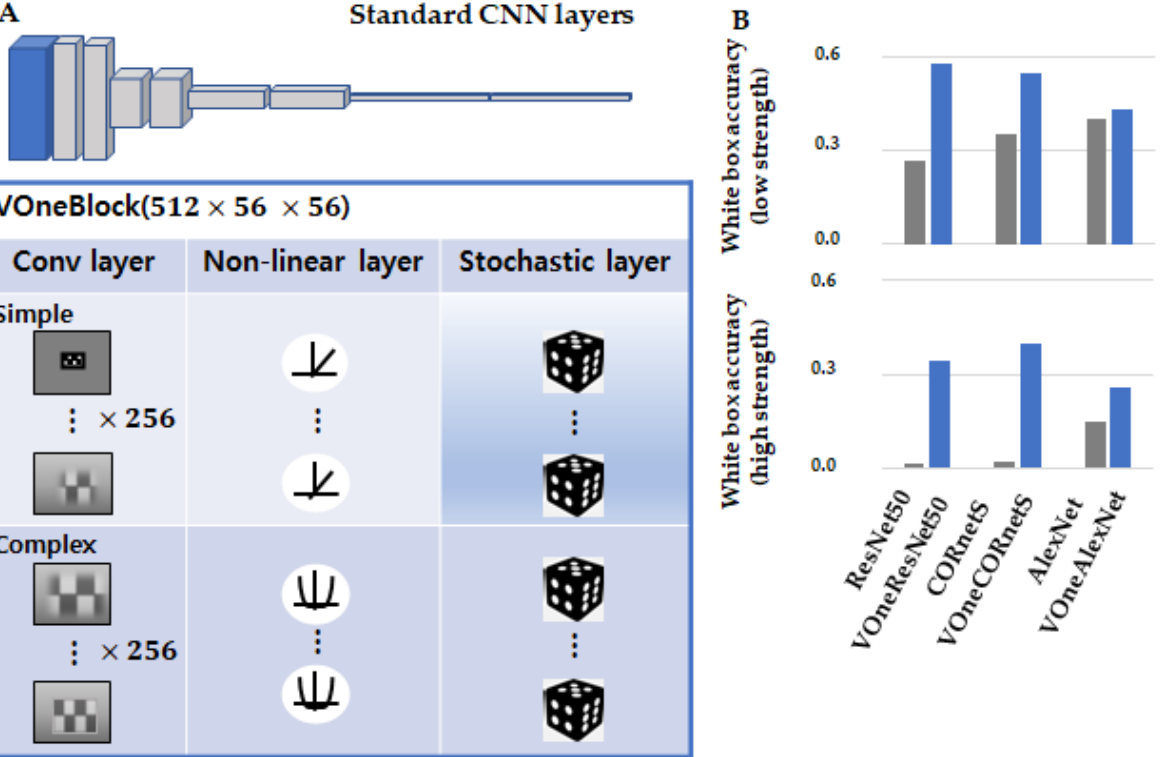
Figure 30. The ( A ) shows VOneBlock is based on the LNP framework for the V1 area of the primate visual cortex and includes Gabor filters, basic and advanced cellular nonlinearities, and a generator of randomness that mimics V1 neurons. The ( B ) shows the performance analysis of VOneNet. VOneNet in [157] is a hybrid CNN model consisting of VOneBlock and a back-end network modeled after a standard CNN, such as ResNet or AlexNet. VOneBlock is